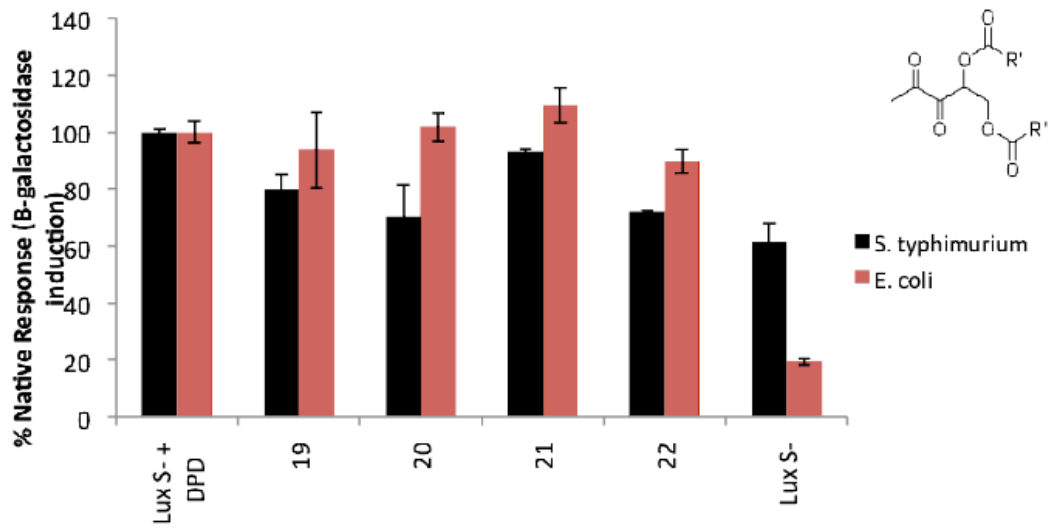
Figure 3. Black bars: AI-2 or analogs-mediated expression of β-galactosidase in S. typhimurium (MET715: LuxS − ). Pink bars: AI-2 or analogs-mediated expression of β-galactosidase in E. coli LW7/LuxS − . AI-2 or bis -ester analogs of AI-2 (20  M) were added to the bacterial strains, which do not produce their own AI-2. Compounds 19 – 22 represent ester-protected DPD analogs: 19 : DPD bis- methyl ester; 20 : DPD bis- propyl ester; 21 : DPD bis- butyl ester; 22 : DPD bis- pentyl